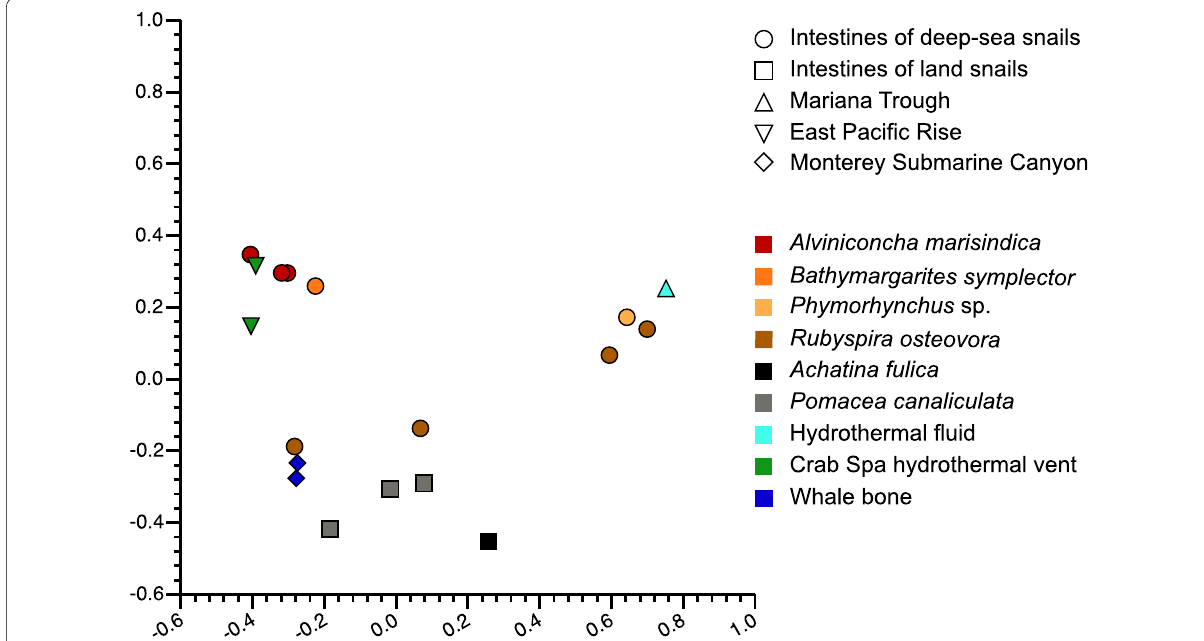
Fig. 2 Principal coordinates analysis of three intestinal samples of Alviniconcha marisindica , six intestinal sample of other three deep‑sea snails, four intestinal sample of two land snails and five environmental samples of three deep‑sea habitats at the level of OTUs (97% sequence similarity). Different shapes represent the location of environmental samples and the snails from marine and land. Different colours represent the species names of all the snails and the types of deep‑sea habitats. A. marisindica samples are clustered together with deep‑sea scavenger Bathymargarites symplector and Crab Spa hydrothermal vent and well separated from other snails and environmental